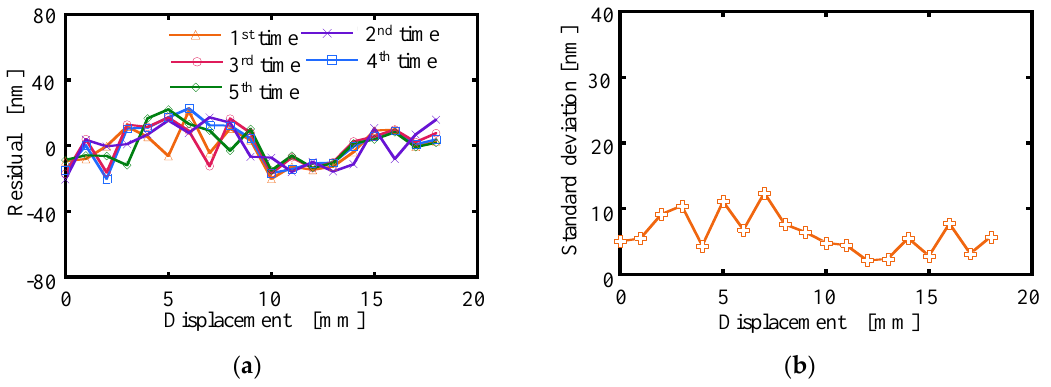
Figure 17. Comparison results: ( a ) residual of measured displacement by the NMM-1 and 3DOFLM systems with wavelength correction; ( b ) standard deviation of five measurements.